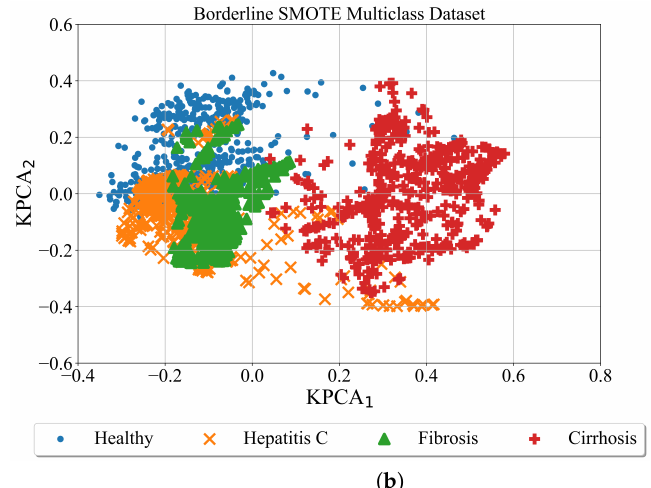
Figure 8. The results of Borderline SMOTE oversampling technique application on binary and multiclass dataset. ( a ) Borderline SMOTE oversampled Binary Dataset; ( b ) Borderline SMOTE Oversampled Multiclass